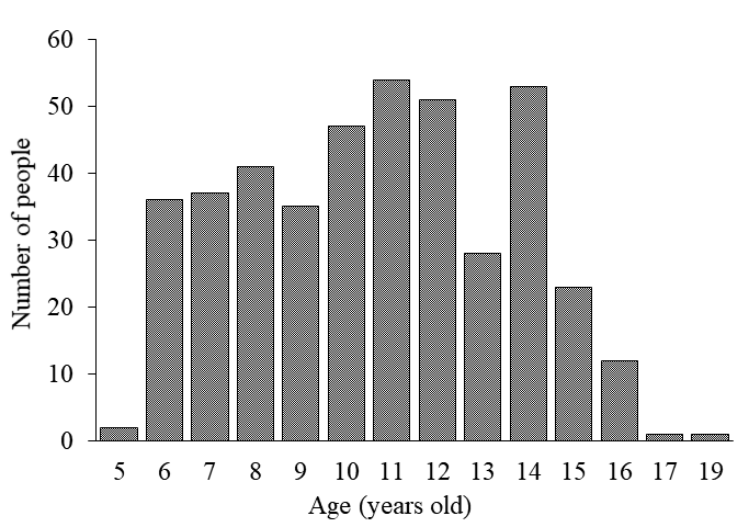
Figure 1. The distribution of subjects at each age: The ages of the participants in this study were mainly distributed from 6 to 16 years. The average age was 10.6 years.